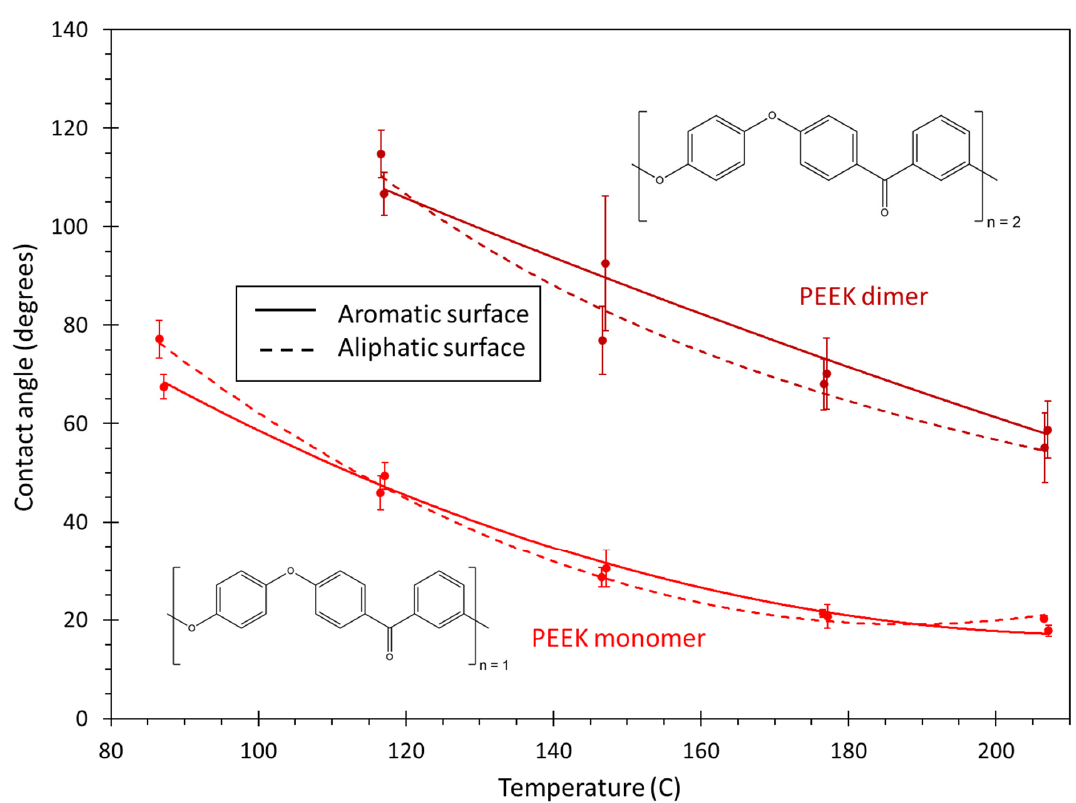
Figure 20. Plot of contact angle vs. temperature for PEEK. The lines are curve fits to the data, and the error bars represent the standard error of replicate predictions.